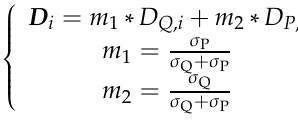
1 is 5 in Equation